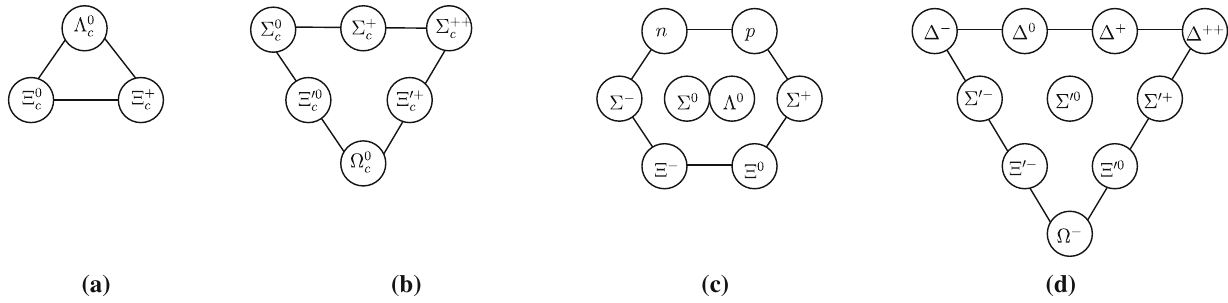
a ), sextet T c 6 to be ( b ). The light baryon c ¯ 3 to be (